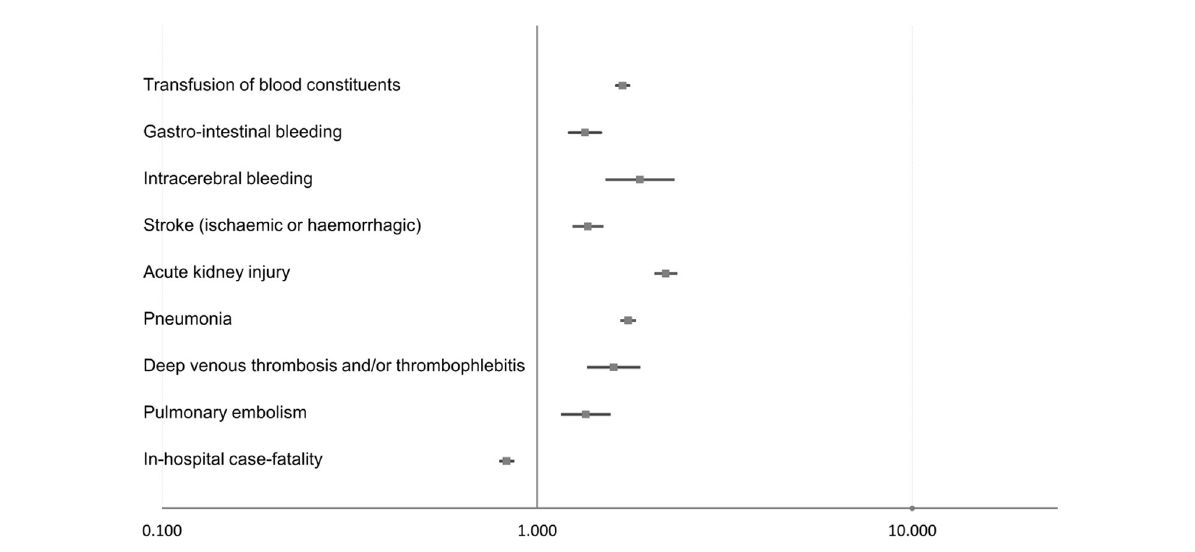
FIGURE2 Impact of therapeutic hypothermia on adverse events during hospitalization in STEMI patients with CPR (multivariable logistic regression